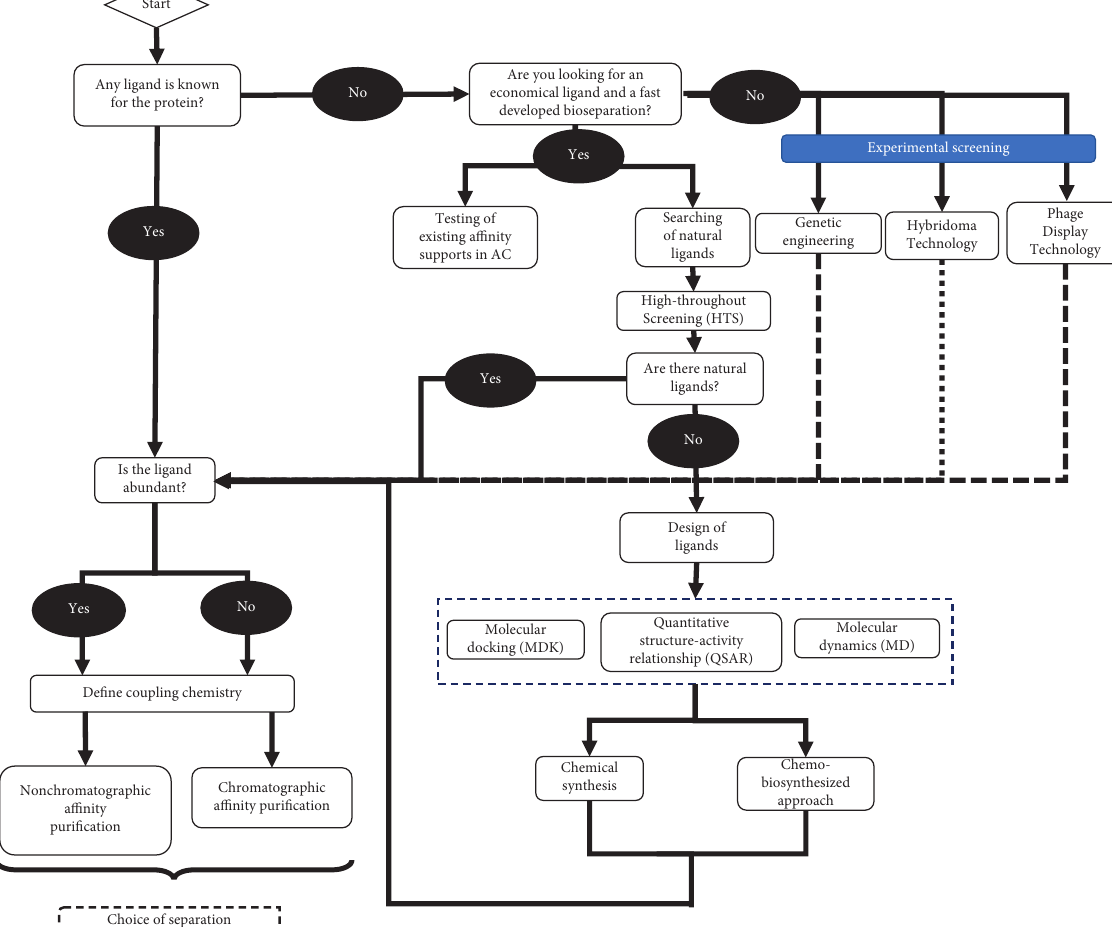
Figure 4: Ligand selection for an affinity-based bioseparation for PEGylated